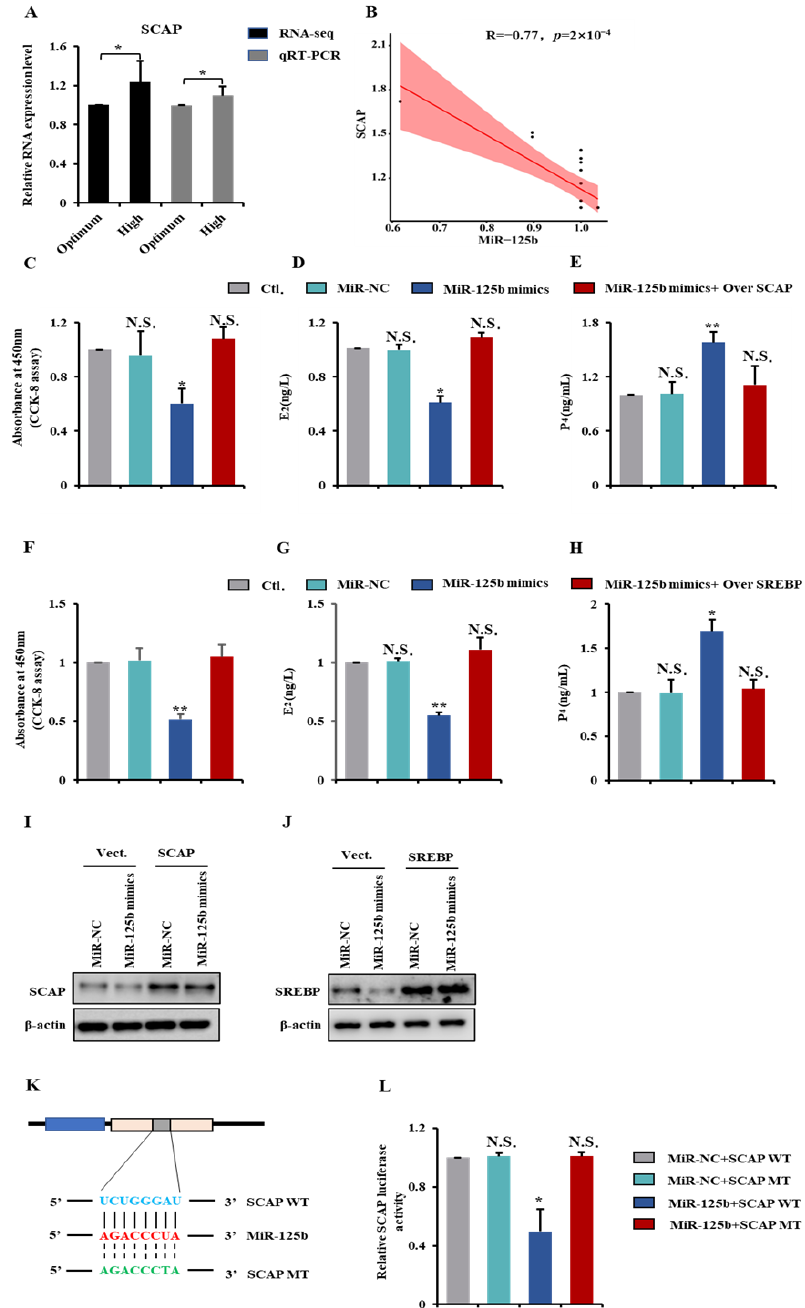
Figure 6. MiR-125b regulates GCs proliferation and steroidogenesis and by targeting SCAP-SREBP axis. ( A ) The qRT-PCR validations and RNA-seq of SCAP in GCs from in different glucose treatment groups. ( B ) Pearson’s correlation was determined between SCAP and MiR-125b. ( C ) MiR-125b or pcDNA3.1-lncGSAR and MiR-125 mimics were co-transfected into GCs for CCK-8 assay. ( D , E ) The concentrations of E 2 and P 4 determination in GCs transfected with MiR-125b mimics, i.e., pcDNA3.1- lncSCAP and MiR-125 mimics. ( F ) CCK-8 assay of GCs at 48 h after transfection of MiR-125b mimics plasmid or pcDNA3.1-lncSREBP and MiR-125 mimics. ( G , H ) The concentrations of E 2 and P 4 deter- mination in GCs transfected with MiR-125b mimics, i.e., pcDNA3.1-lncSREBP and MiR-125 mimics. ( I , J ) Western blot detection of SCAP ( I ) and SREBP ( J ) in GCs after overexpression of MiR-125b. ( K ) Schematic depicting the interaction of MiR-125b with wild-type (blue) and mutant SCAP (green). Red nucleotides indicate the seed sequence of MiR-125b. ( L ) The regulatory relationship between MiR-125b and SCAP was assessed using a dual-luciferase reporter gene assay. * p < 0.05; ** p < 0.01. N.S., not